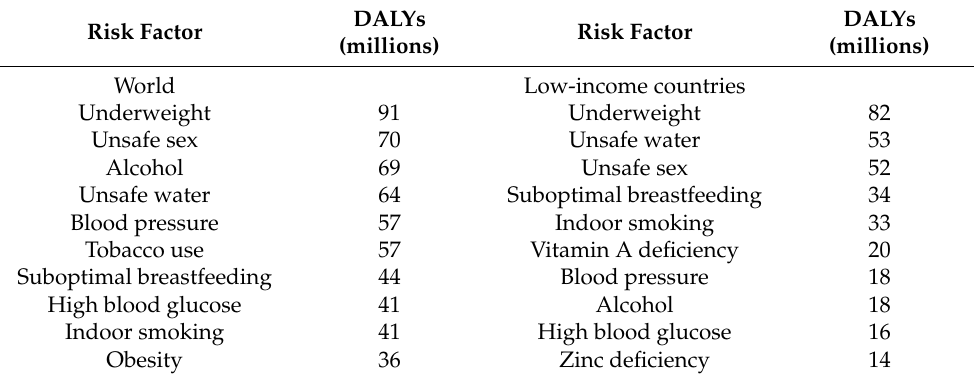
Table 1. Ranking of the ten leading health risk factor causes of Disability Adjusted Life Years (DALYs) in low-income countries [32]. Risk Factor